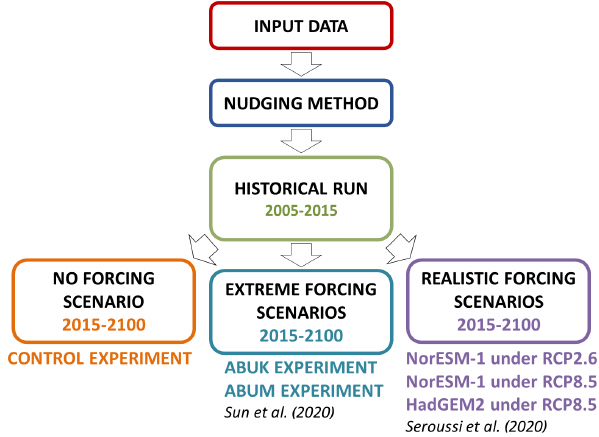
Figure 2. Flow chart of the experimental